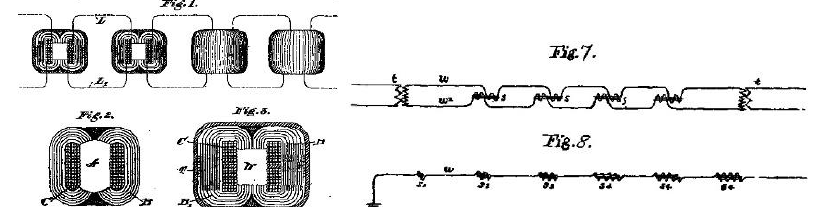
Fig. 4. Load coils of G. Campbell design and their inclusion in the telephone line. Patent GB190016290.